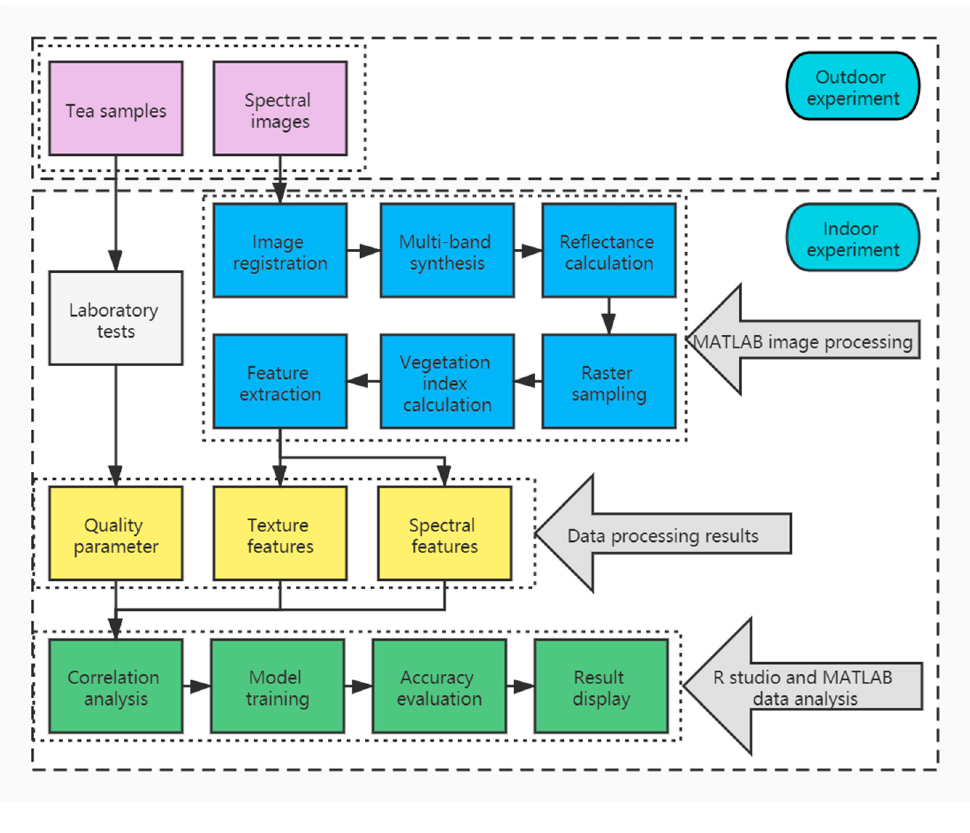
Figure 2. Experimental steps.